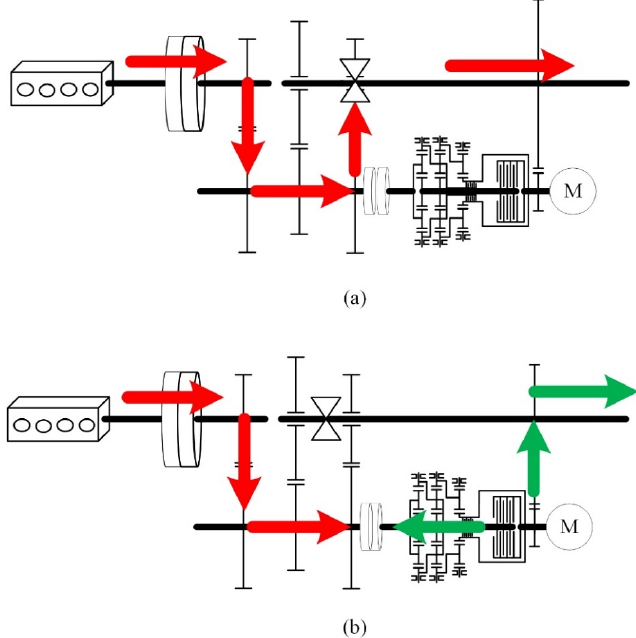
Figure 3. ( a ) Power flow of AMT with gearshift assistant mechanism while in normal cruise. ( b ) Power flow of AMT with gearshift assistant mechanism while in normal cruise.